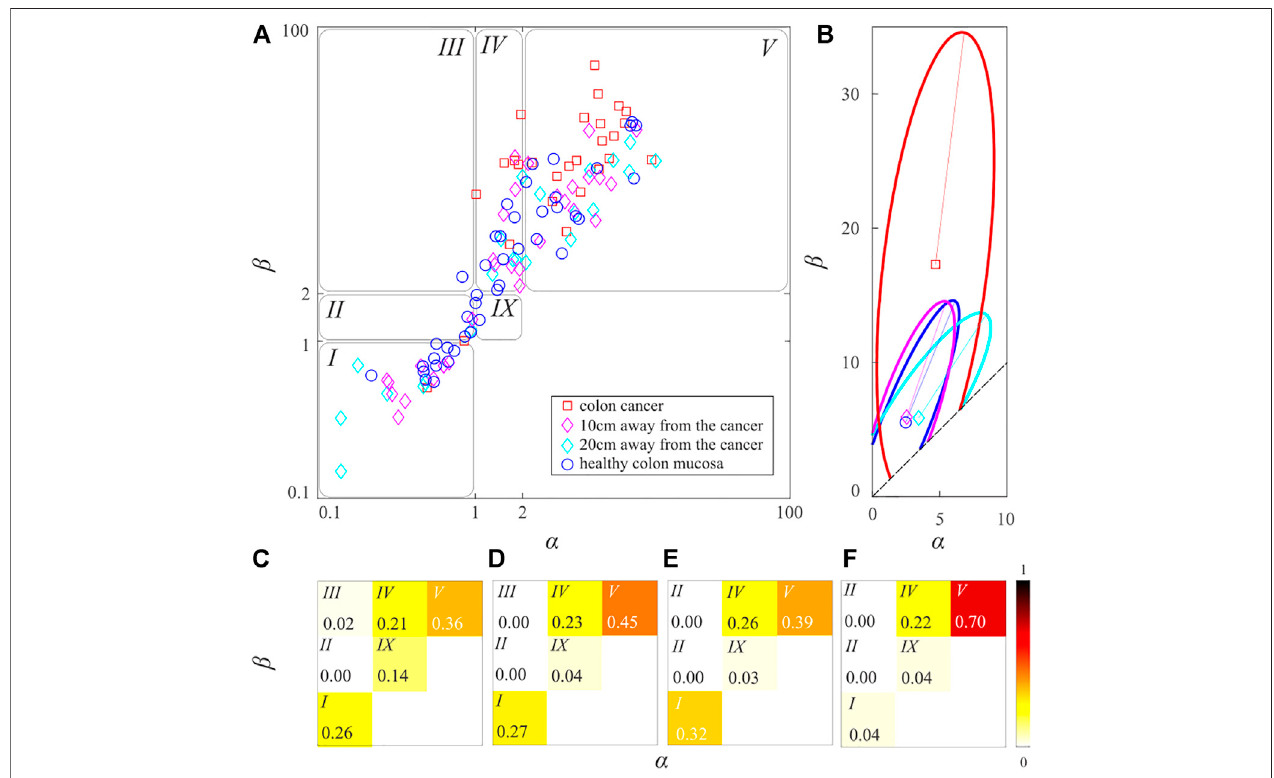
FIGURE 5 | (color online) (A) The scatter-plot of the irreducible beta-distribution parameters. (B) The characteristic ellipses of the healthy samples, samples were taken 20 and 10 cm from the cancer tissue, and samples ofcancer tissue are shown by blue, cyan, magenta, and red lines, respectively. Parts of the curves outside the irreducible sample space were ignored. The shape distribution of (C) the healthy samples, (D) and (E) samples taken 20 and 10 cm far from the cancer tissue, and (F) samples of the cancer tissues. The relative frequency of the forms is shown by the different tones of the red color, according to the show colorbar.